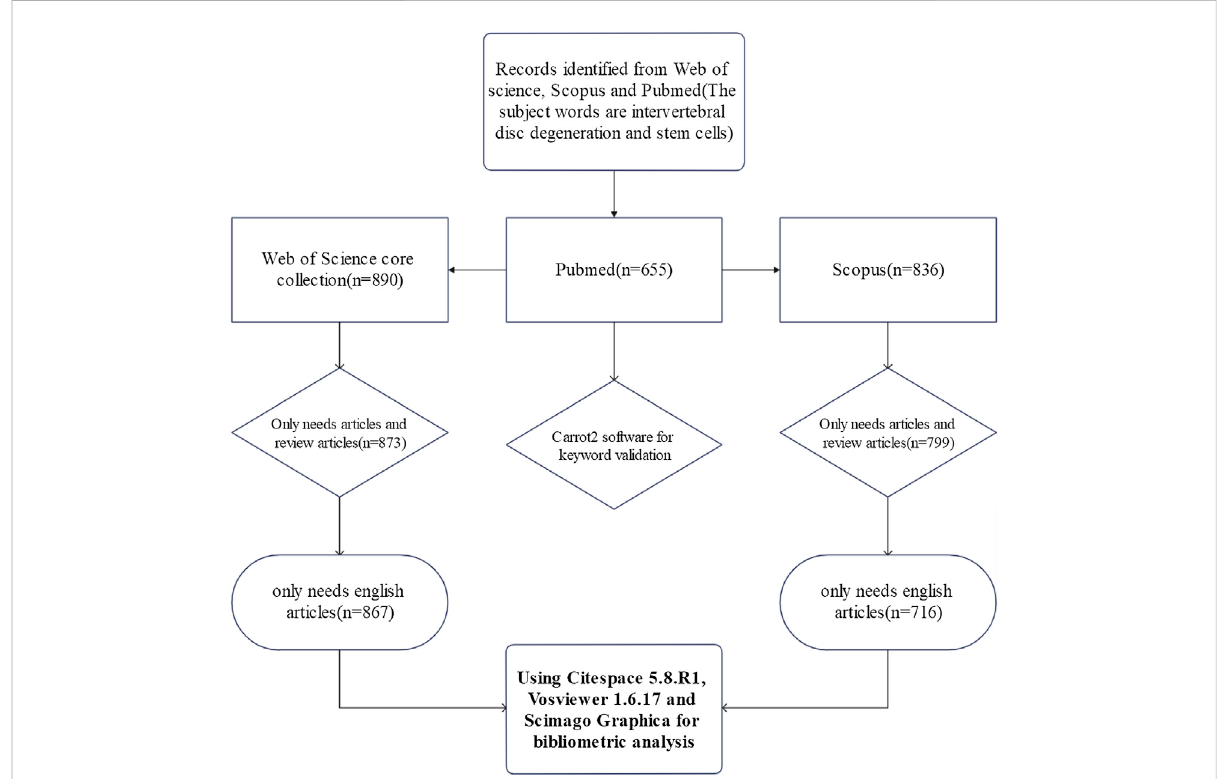
FIGURE 1 The fl ow chart of search strategy about SCs therapy for IDD. Full search completed on 27 December 2021. 890 articles were searched from WOSCC and 836 studies were identi fi ed from Scopus. We only needed reviews and original articles and chose English as the language type. Eventually, 867 articles in WOSCC and 716 articles in Scopus were included in the